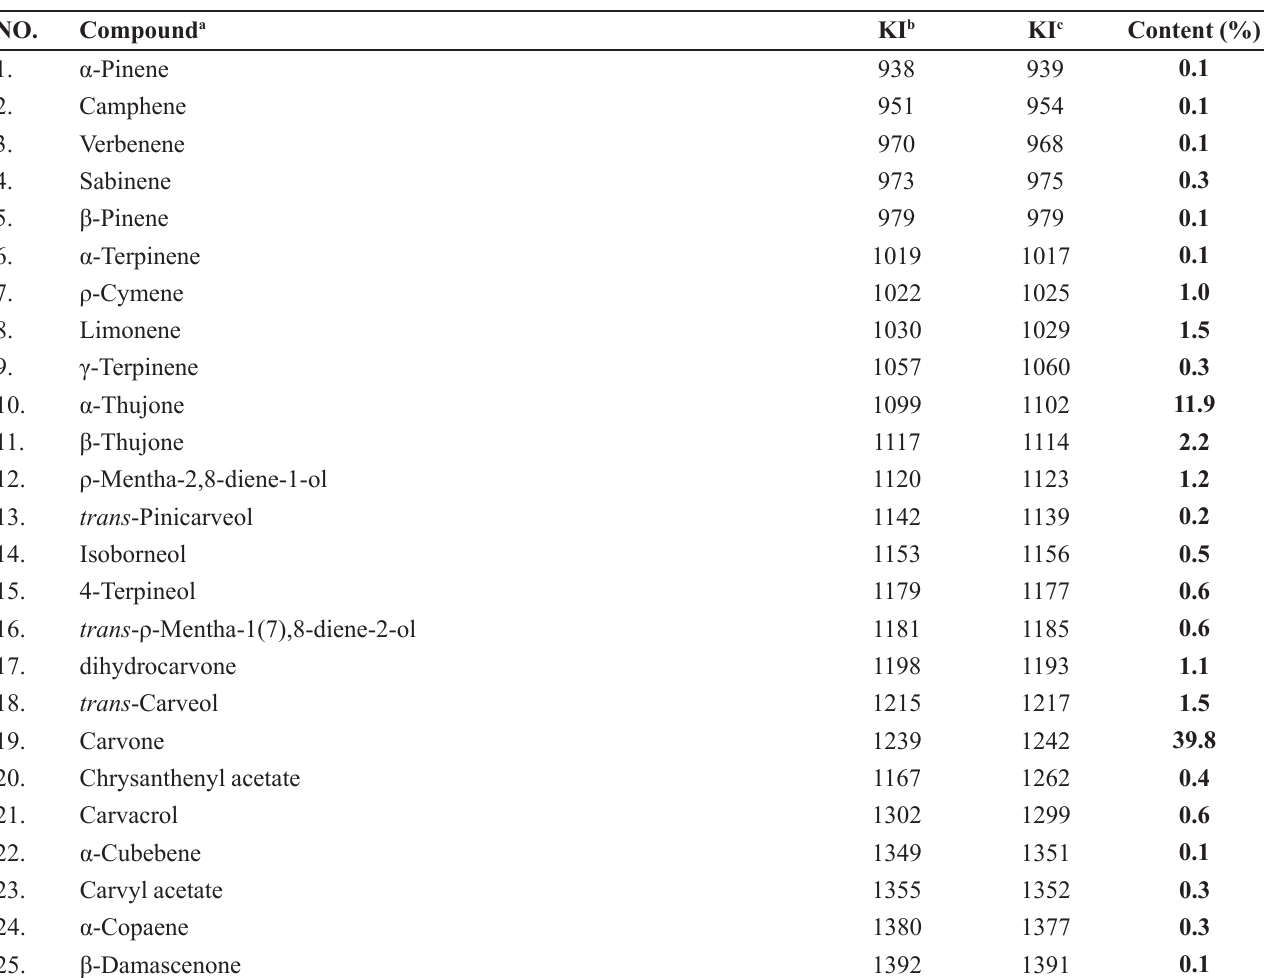
TABLE II - GC-MS analysis of TBEO